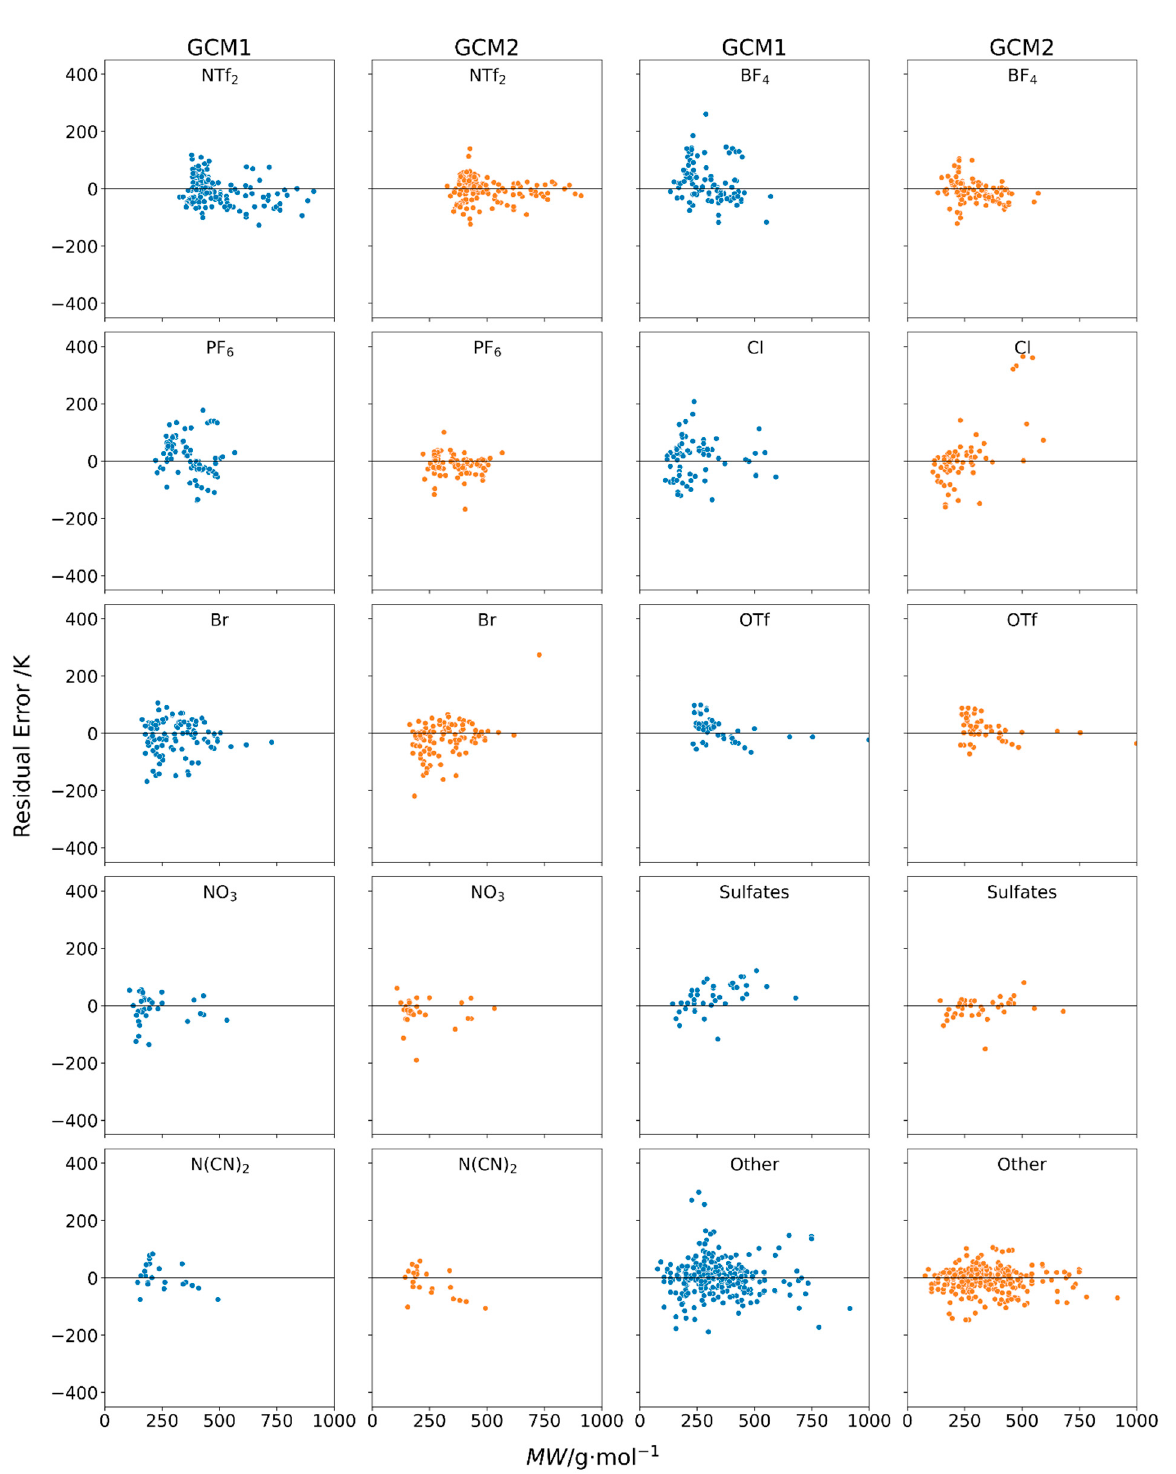
Figure 5. Individual residual plots of error versus molecular weight using GCM1 (blue) and GCM2 (orange) to estimate melting points for ILs containing several different anions.